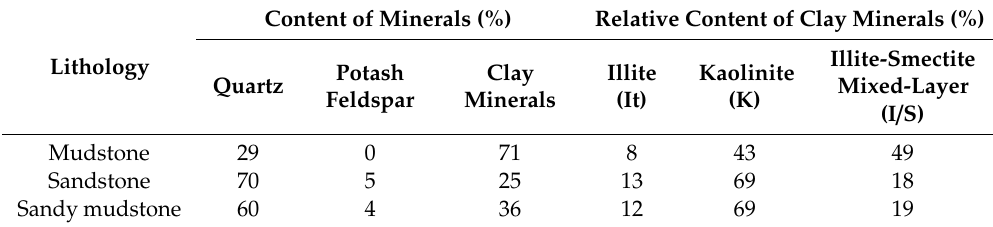
Table 3. Test results of rock mineral composition. Content of Minerals